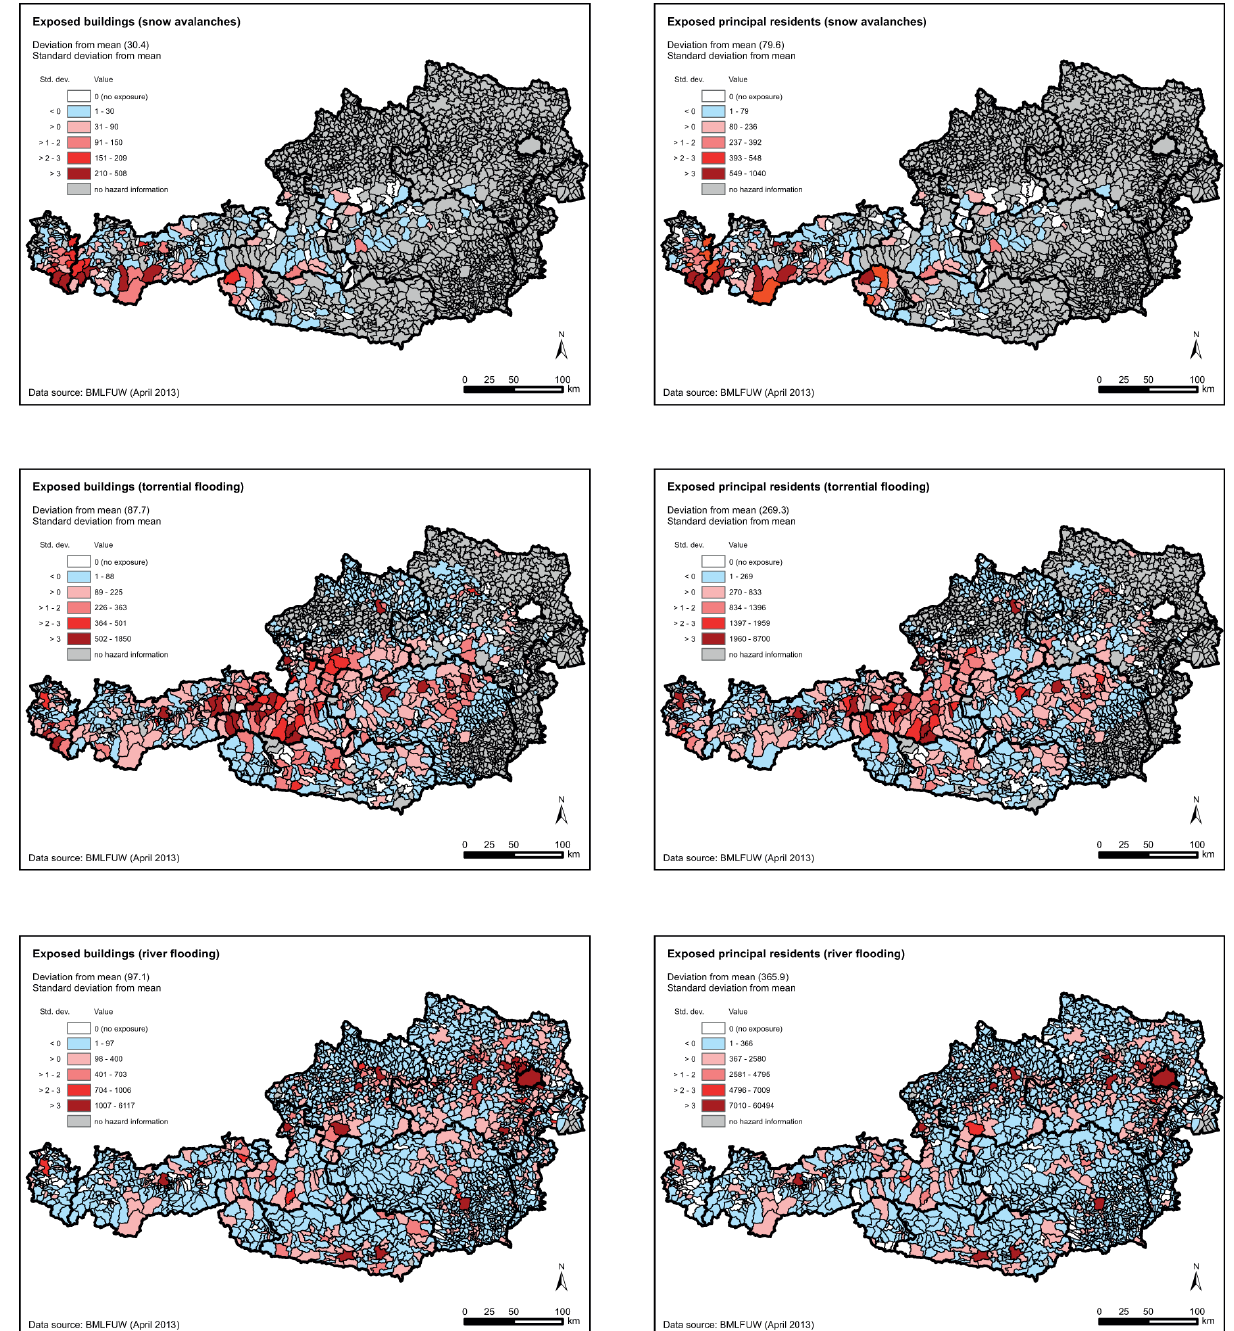
Figure 3. Number of buildings and primary residents exposed to snow avalanches, torrential flooding and river flooding in Austria, shown as deviation from